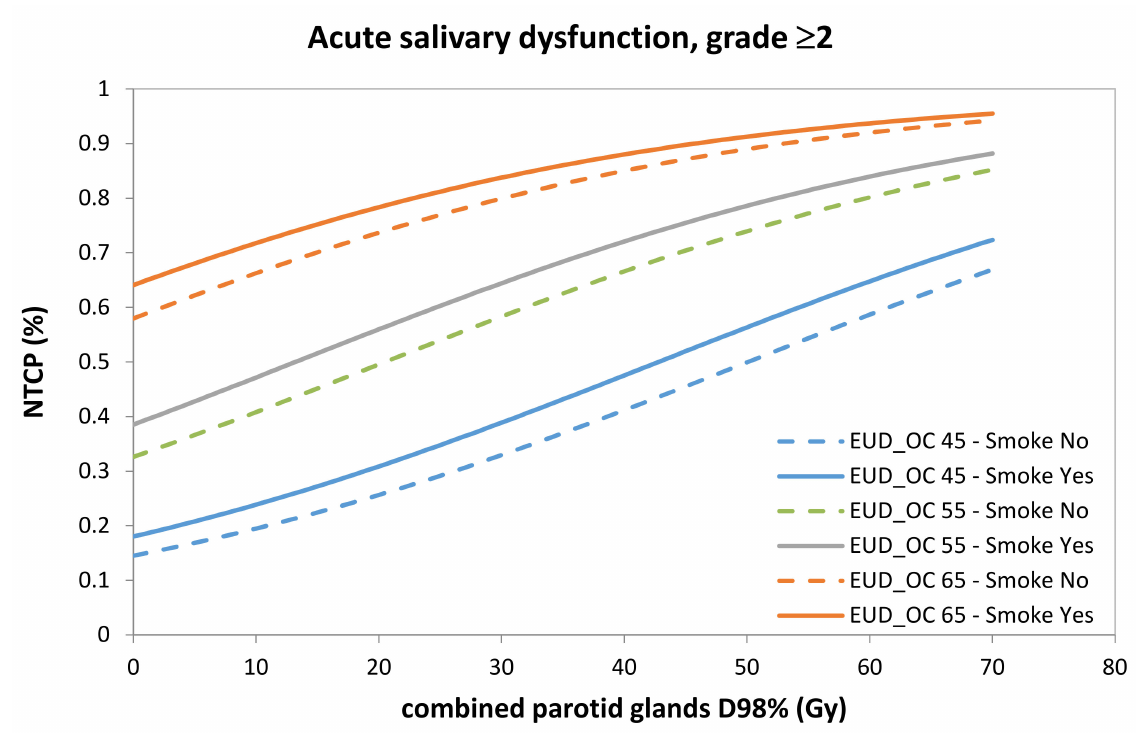
Figure 3. Probability of grade ≥ 2 acute salivary dysfunction as a function of combined parotid glands D98%. Three dose levels for the equivalent uniform dose (EUD) for oral cavity (OC) calculated with n = 0.05 are represented: EUD to OC = 45 Gy in blue; EUD to OC = 55 Gy in green; and EUD to OC = 65 Gy in red. Dashed and continuous curves correspond to negative or positive smoking history, respectively.